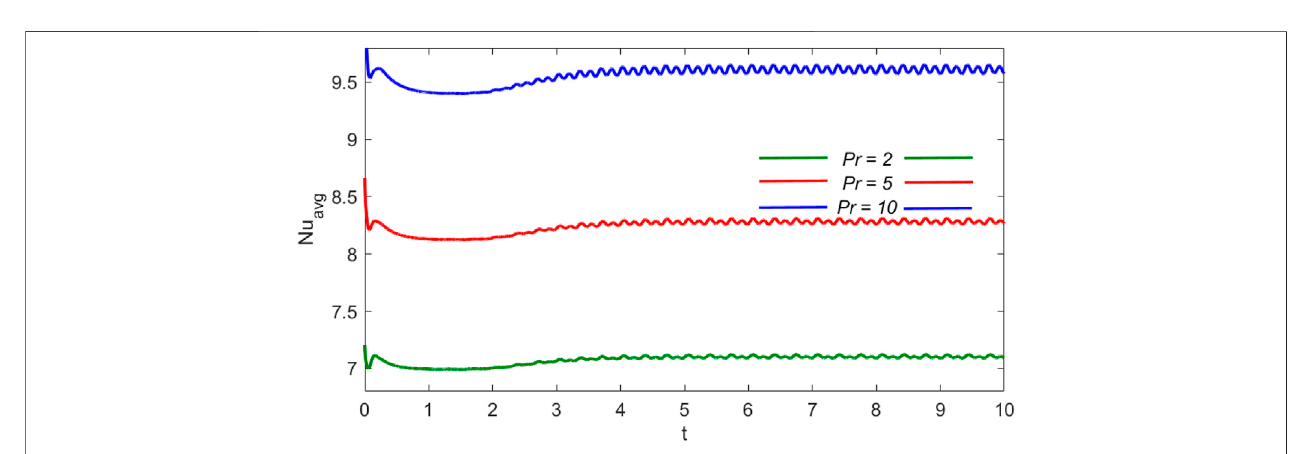
FIGURE 12 | In fl uence of Pr on Nu